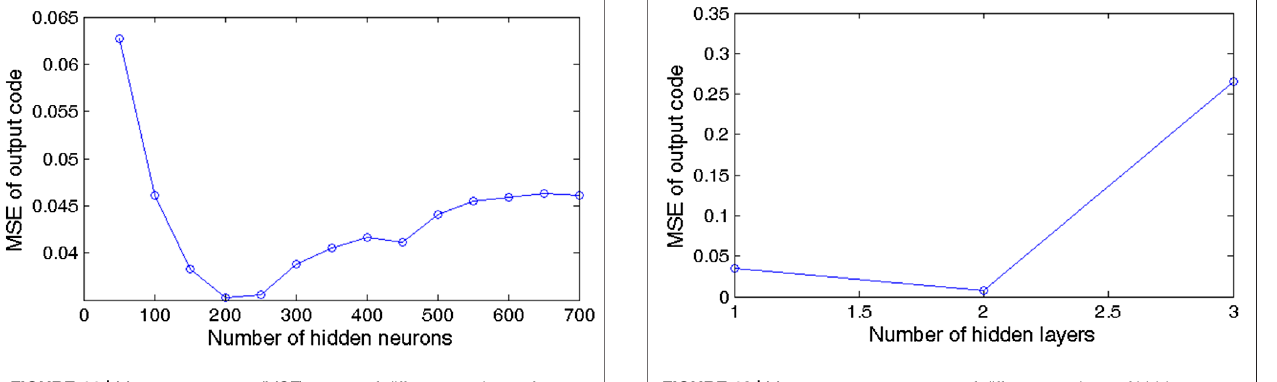
FIGURE 11 | Mean square error (MSE) curves of different numbers of hidden neurons.